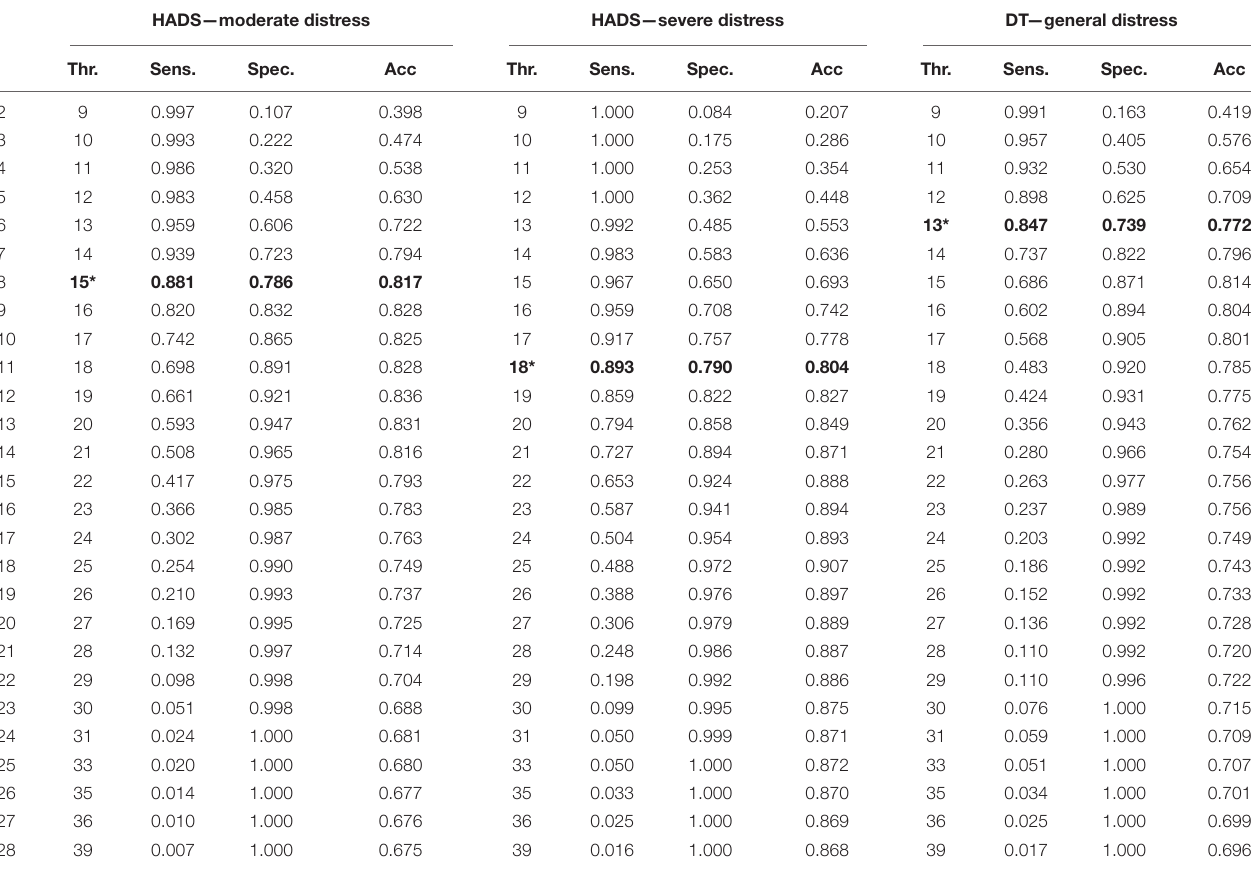
TABLE 4 | Study 2. Results of the ROC